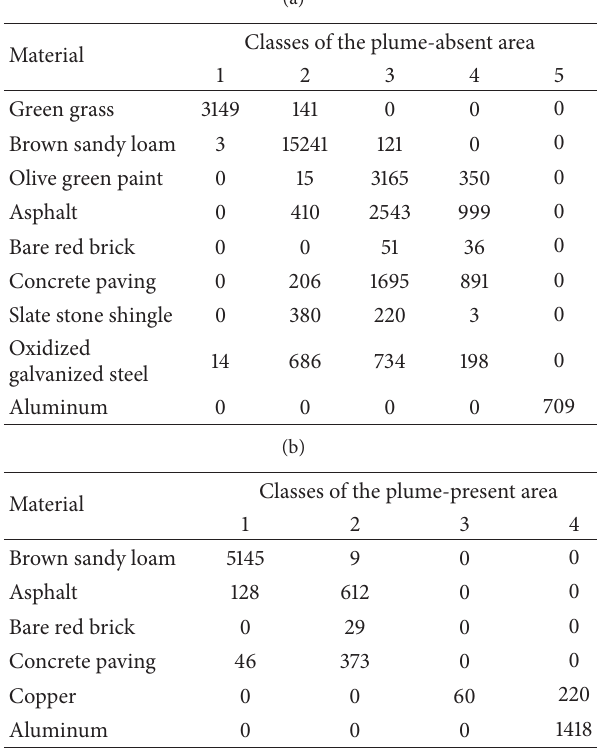
Table 1: Confusion matrix of the classifications performed on the synthetic refinery